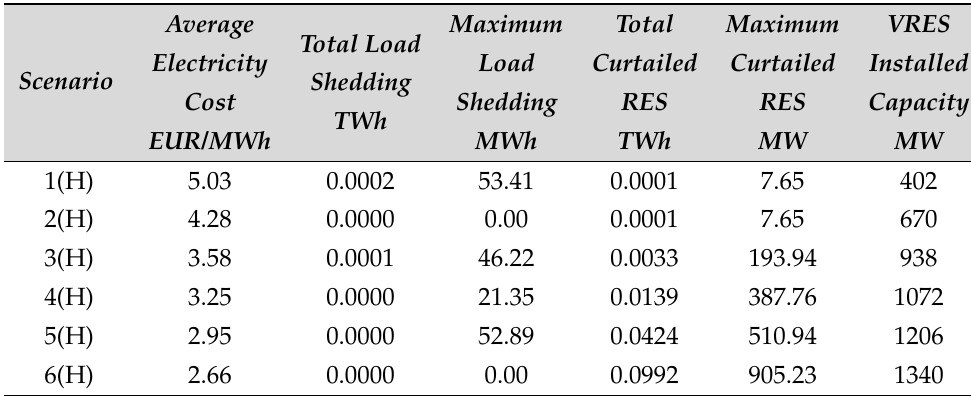
Table 7. Electricity Cost, Load Shedding,